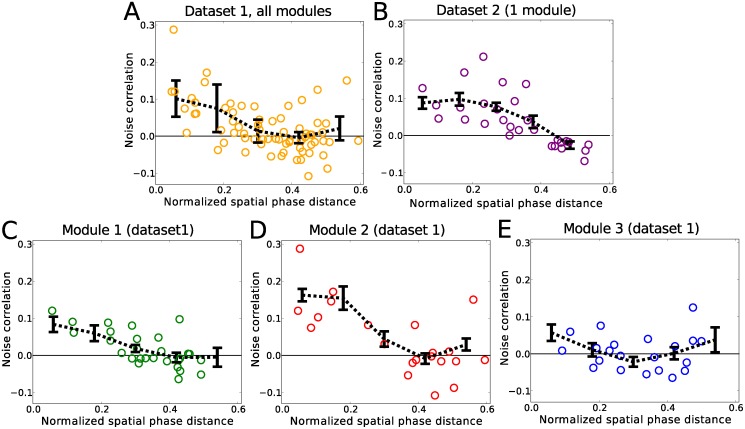
Noise correlations versus phase distance.(A) shows all three modules of data set 1 combined, while (B) shows the one module of data set 2. For the smaller modules of data set 1 (C, D) the noise correlations are positive for small phase differences while they approach zero for larger phase separations. No significant pattern can be observed for the cells from the largest module of data set 1 (E). The distance in phase was normalized by the average spacing of the spatial fields in each module. In each plot, the circles represent the inferred values using the full data length. The noise correlations were calculated by binning the environment into 7.5 × 7.5 cm spatial bins. The black lines show the average values of the correlations calculated from 20 random partitions (see Material and Methods) of the data. The error bars are the standard deviation of the mean values over these 20 random partitions. Note that the normalized maximal phase distance occurs at the minimum overlap between the two commonly oriented hexagonal patterns and is 0.5/cos(30) ≈ 0.6.